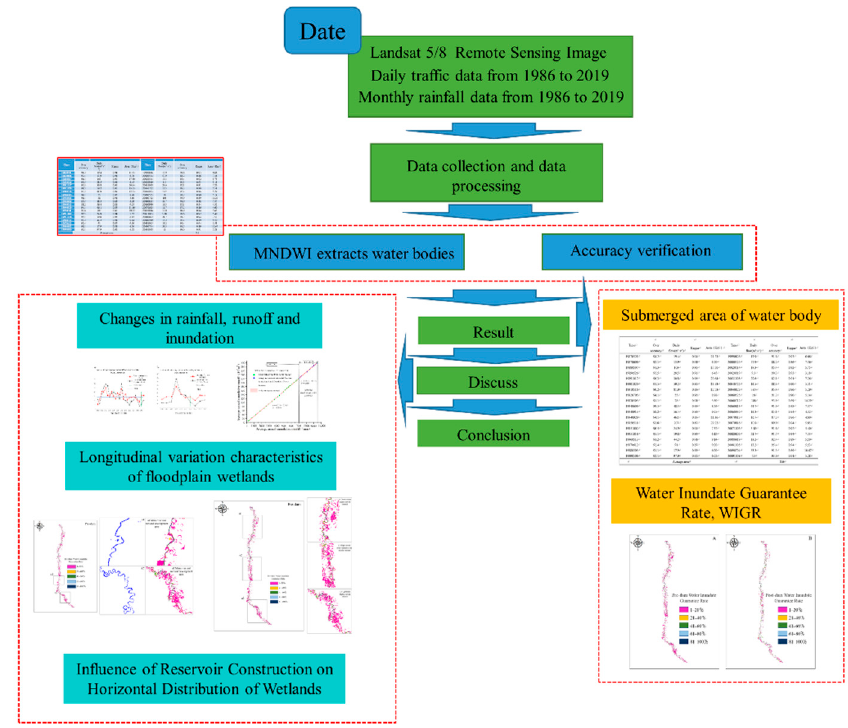
Figure 2. Flow chart.